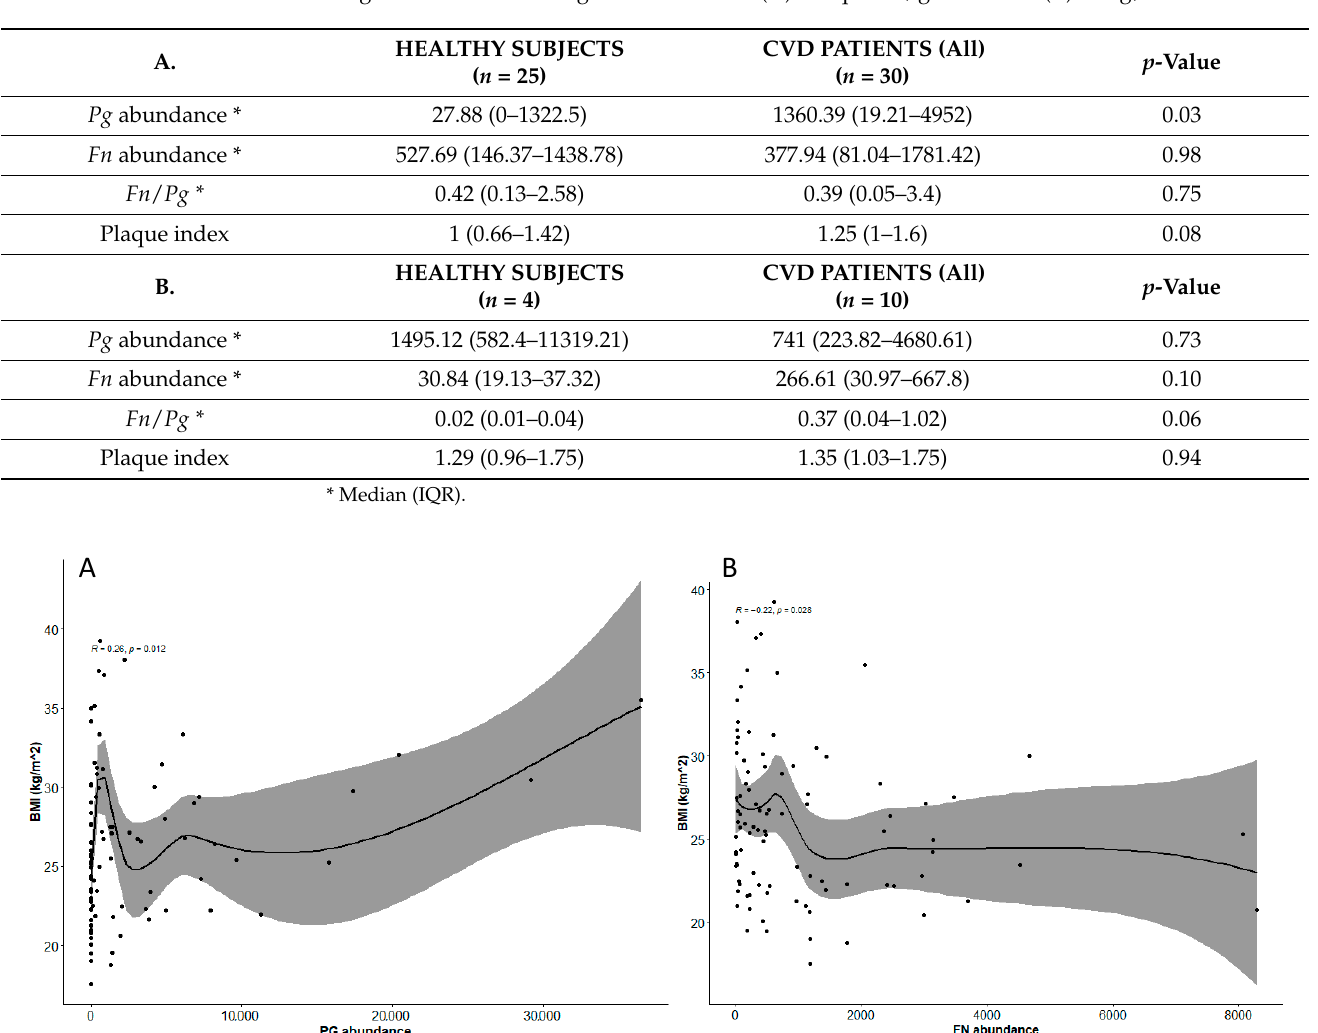
Table 5. Pg and Fn abundance: Comparison between healthy subjects and all patients with previ- ously diagnosed CVD according to BMI less than ( A ) or equal to/greater than ( B ) 30 kg/m 2 .